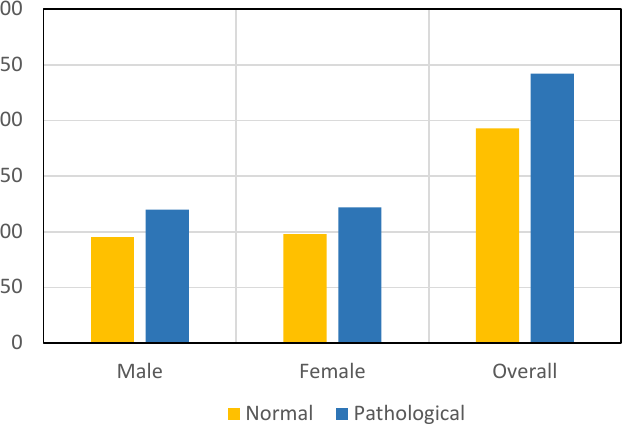
Figure 2. Selected male and female image datasets used for training and validation of the proposed model from the ImageNet database.